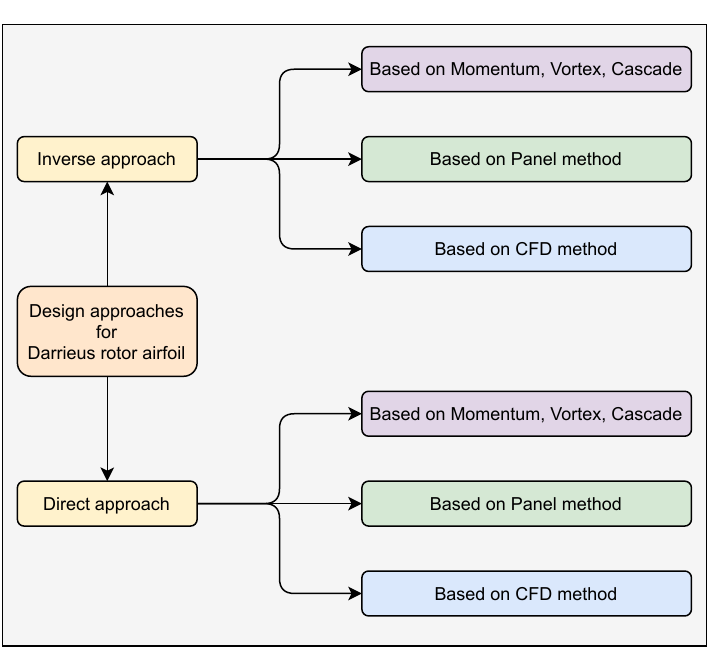
Figure 5. Summary of the design method for Darrieus rotor’s airfoil